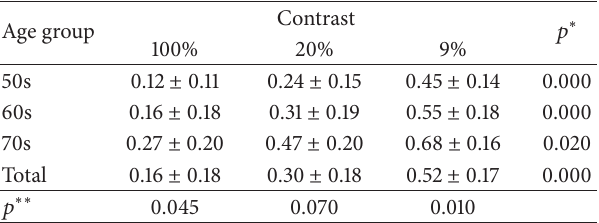
Table 2: Simulated visual acuity (mean VA logMAR ± SD) of nor- mal eyes ( 𝑁 = 93 ) at different simulated contrast levels compared by age group. Contrast Age group